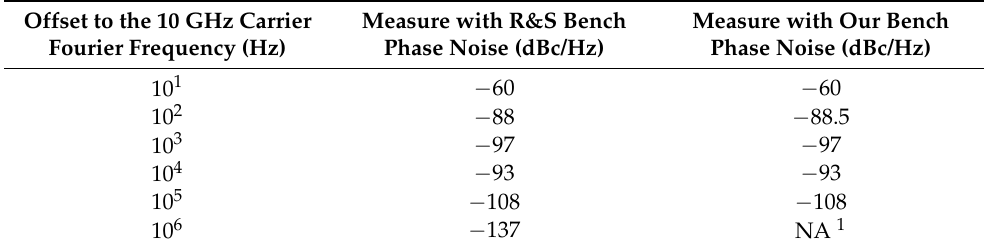
Table 1. Phase noise of an Anritsu synthesizer with an output power of 10 dBm at 10 GHz, measured by our instrument and by the commercial Rohde and Schwarz (R&S) bench.